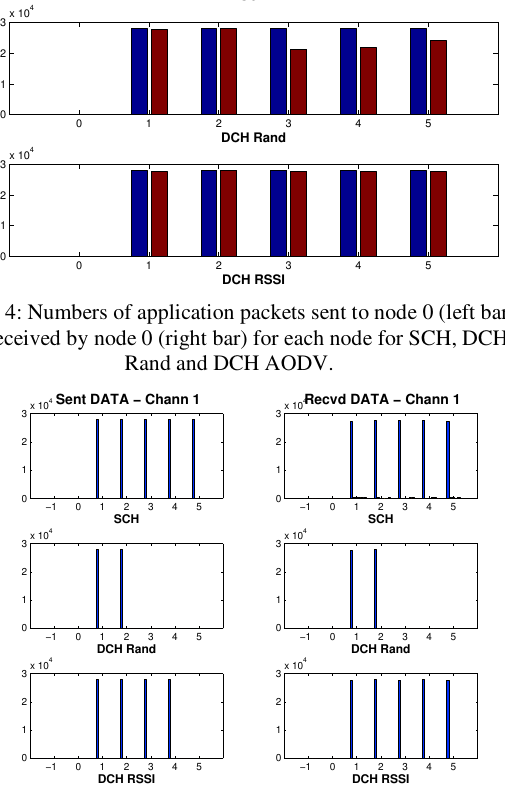
Figure 5: Sent and received AODV DATA packets on Channel 1 Figure 8: Sent and received MAC DATA packets on Channel 2 For SCH all DATA packets were sent on channel 1. Most DATA packets were sent from source to node 0 in one hop